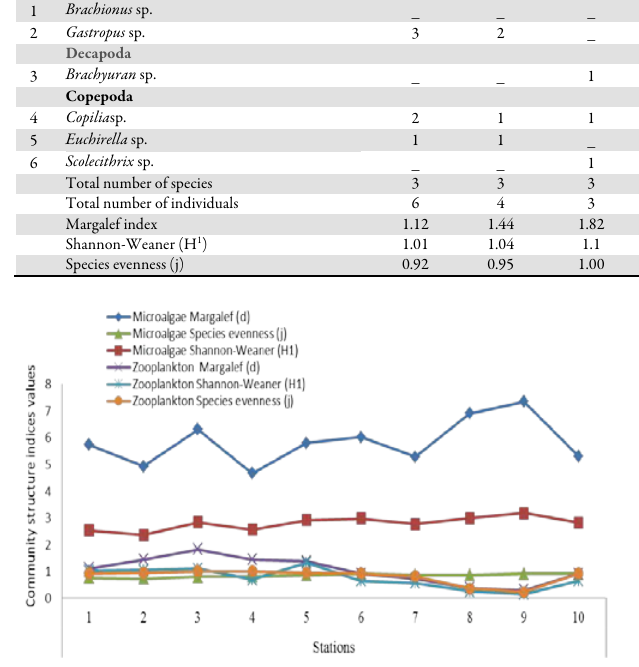
Fig. 3. Comparison of plankton community structure indices at Ibefun River, Ogun